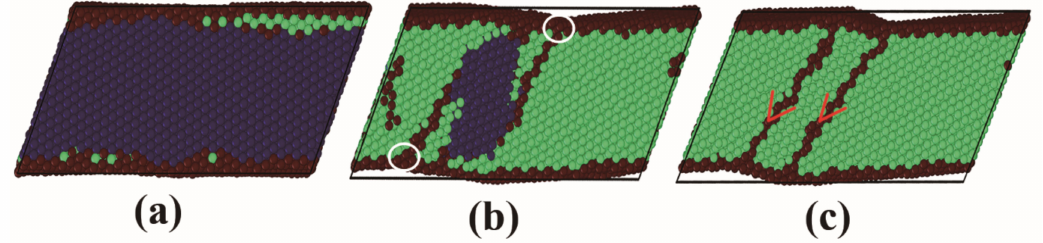
Figure A2. Snapshots of the ongoing martensitic phase transition in film 2 with the (110) fcc surface at 300 K. The simulation is performed using the Müller potential. The colors denote the local crystal structure as in Figure 5. The plane shown is the original (111) fcc plane. ( a ) First nucleation at the free surface at a shear angle of 23.1 ◦ ; ( b ) Growth of the bcc phase at a shear angle of 23.3 ◦ . “Kinks” at the free surface, indicated by the white circles, initiate new nucleation with di ff erent orientation. ( c ) Status at the largest shear angle of 26.5 ◦ . The twin structure is indicated by the red